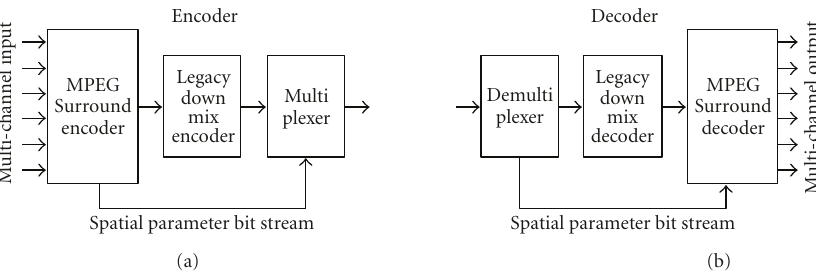
Figure 1: Concept of MPEG Surround. A multichannel audio signal is represented as a downmix signal and accompanying spatial parameters (MPEG Surround encoder). The downmix can be encoded using an existing (legacy) compression method. The decoder separates the spatial parameters from the core coder bitstream (demultiplexer), decodes the downmix, and reconstructs multichannel audio by reinstating the spatial properties (MPEG Surround decoder).